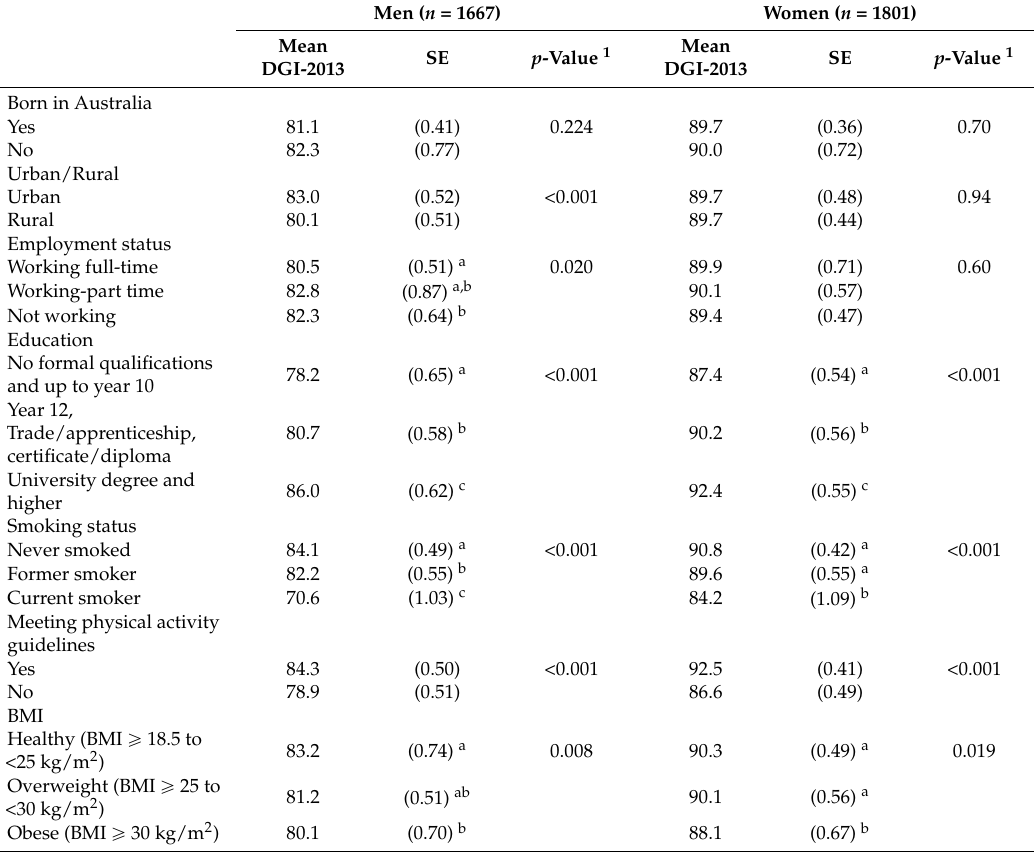
Table 4. Mean and standard error of the 2013 Dietary Guideline Index score according to participant characteristics, Wellbeing Eating and Exercise for a Long Life study at Time 1,